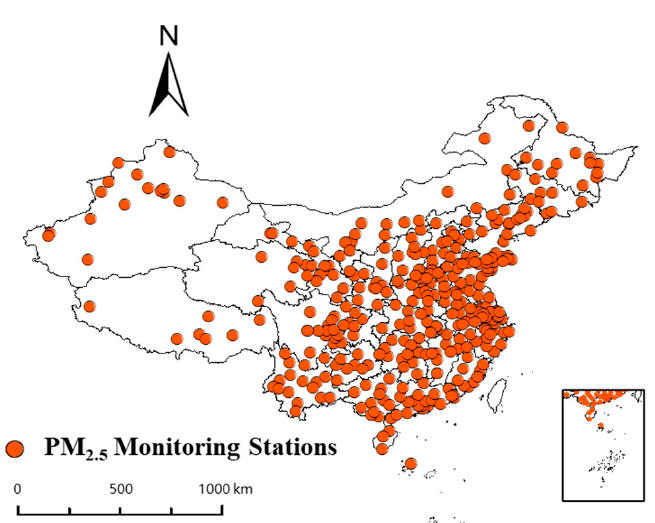
Figure 1. Distribution of PM 2.5 ground monitoring stations in China.